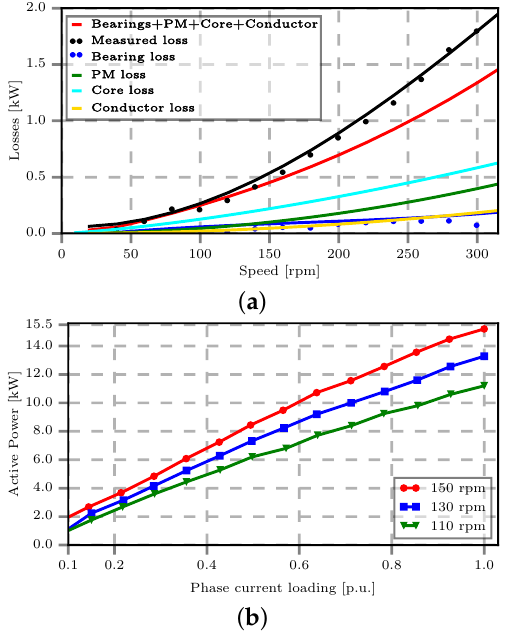
Figure 28. Prototype PMVM performance at constant rotational speeds: ( a ) no-load losses as a function of rotor speed, ( b ) active power as a function of phase current.